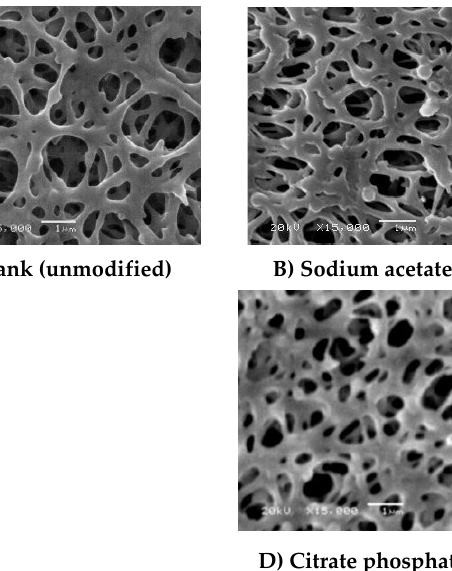
Typical errors: a = ±0.1, b = ±0.1, c = ±0.4, d = ±0.1, e = ±0.1, f =± 1, g = ±0.2.